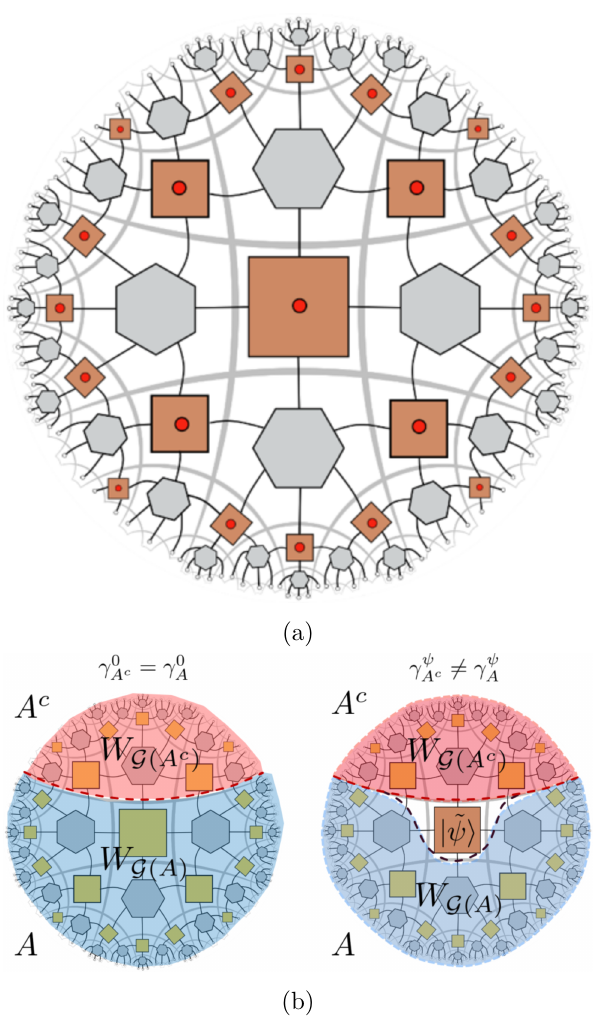
Figure 37. (a) Noisy hybrid code with skewed Bacon-Shor tensors (brown). (b) Dashed curves are “geodesics” that are anchored on the endpoints of boundary regions A , A c . Yellow squares γ 0 ,ψ A,A c denote the | ˜0 i logical state whereas a brown square denotes some superposition | ˜ ψ i = c | ˜0 i + d | ˜1 i or a generic mixed state. The wedges in the left figure also hold for a central tile in the | ˜1 i